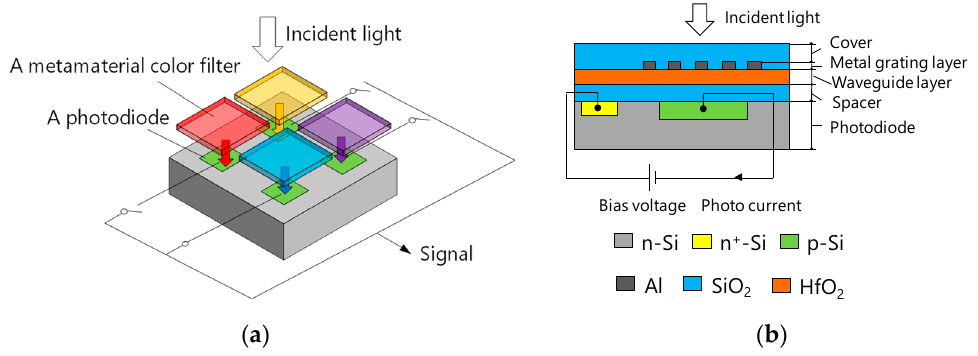
Figure 1. Schematics of proposed devices. ( a ) Perspective view in the case of 2 × 2 color sensors; ( b ) cross-sectional view of one particular color sensor.